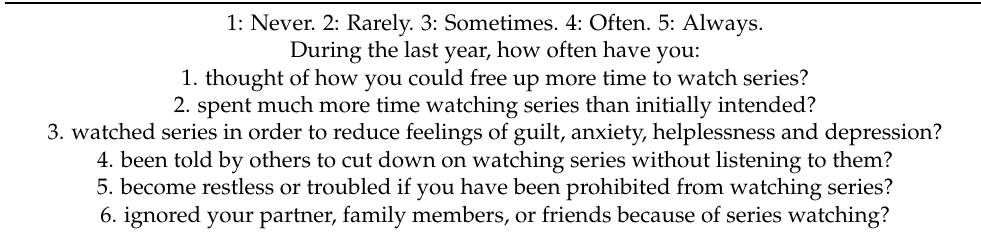
Table A1. The Problematic Series Watching Scale (PSWS), English